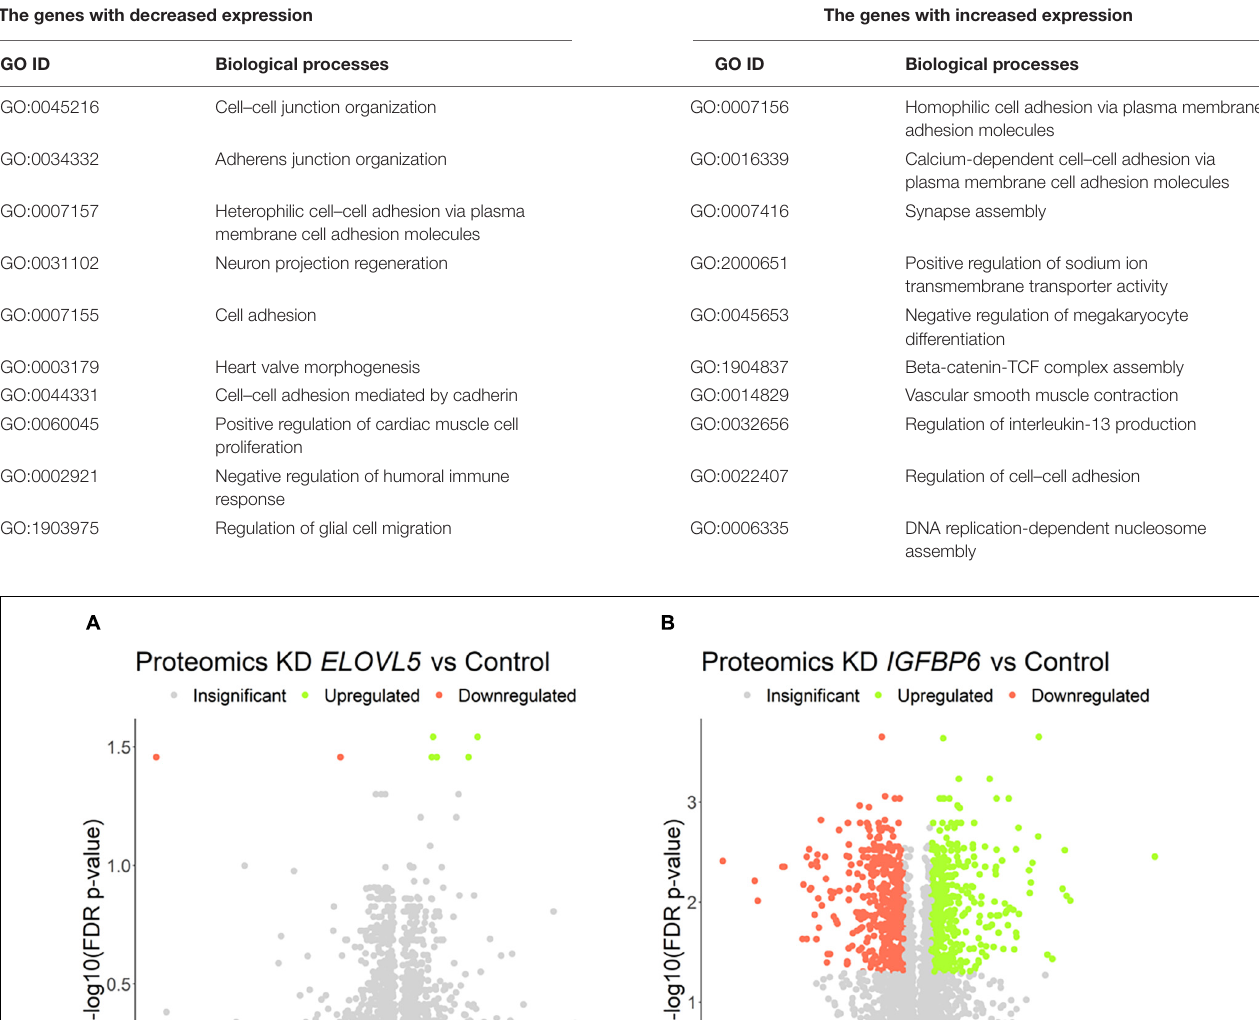
TABLE 2 | Selected enriched biological processes for the genes with a concordantly changed expression after knockdown of the ELOVL5 and IGFBP6 genes. The genes with decreased expression The genes with increased expression